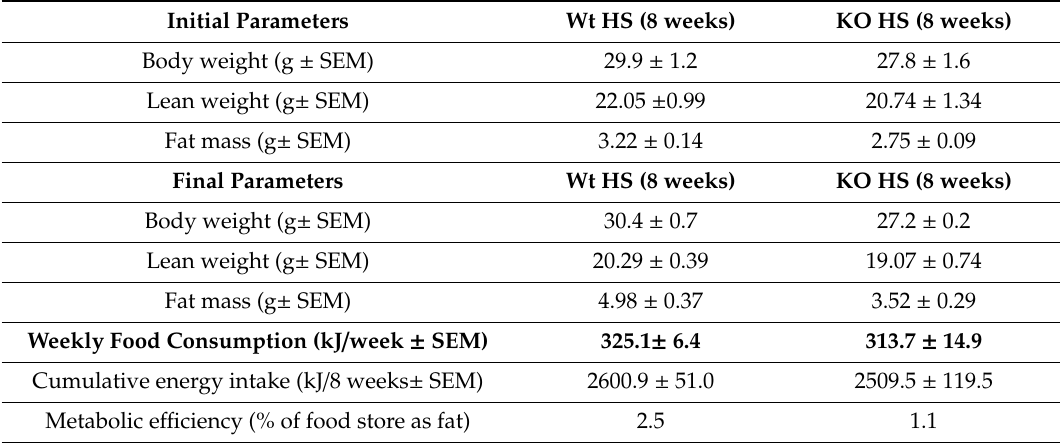
Table 2. Parameters of Elovl2 +/+ (Wt) and Elov2- / - (KO) mice on control HS diet (for 8 weeks). Initial